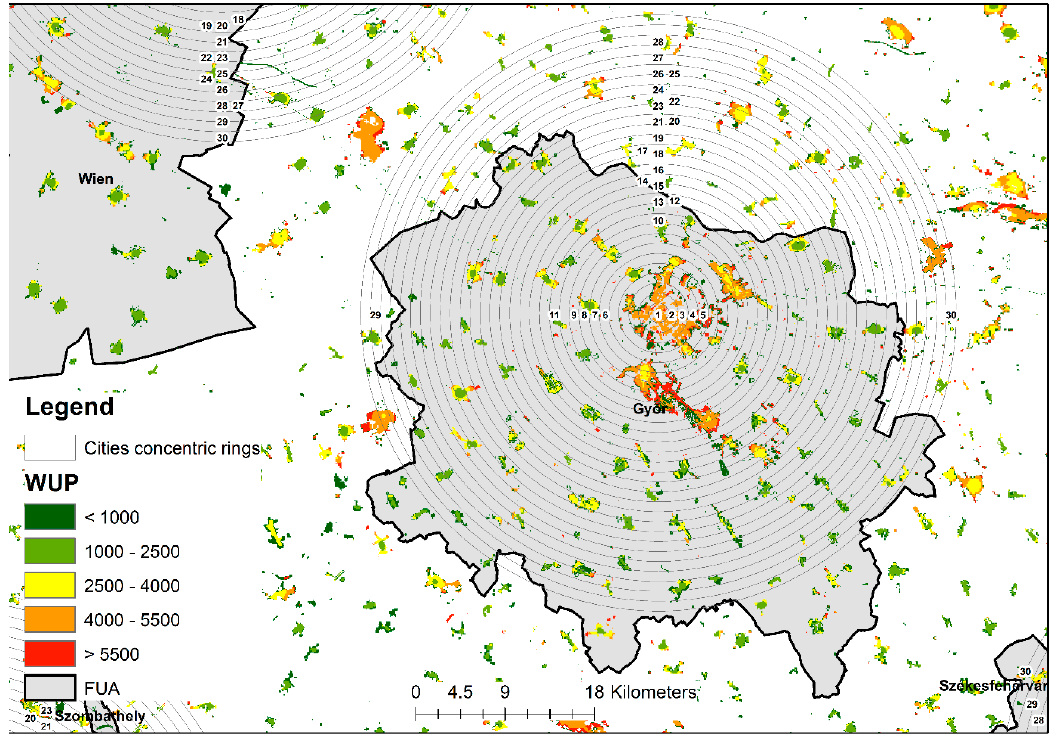
Figure 6. WUP values for the city of Gyor, Hungary using a 2 km horizon of perception.